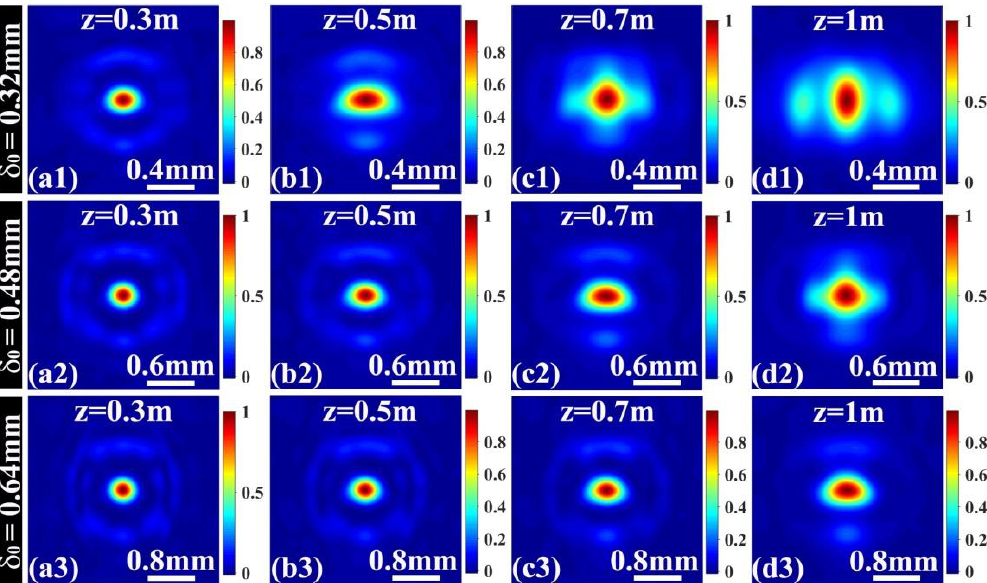
Figure 3. Evolution of the modulus of the square of the degree of coherence of a general partially coherent beam with three different initial transverse coherences propagating in free space. The values of the initial coherence width δ 0 in the first ( a1 – d1 ), second ( a2 – d2 ), and third ( a3 – d3 ) rows are 0.32 mm, 0.48 mm, and 0.64 mm, respectively. With the increase of δ 0 , the degree of coherence distribution remains invariant for a longer distance.